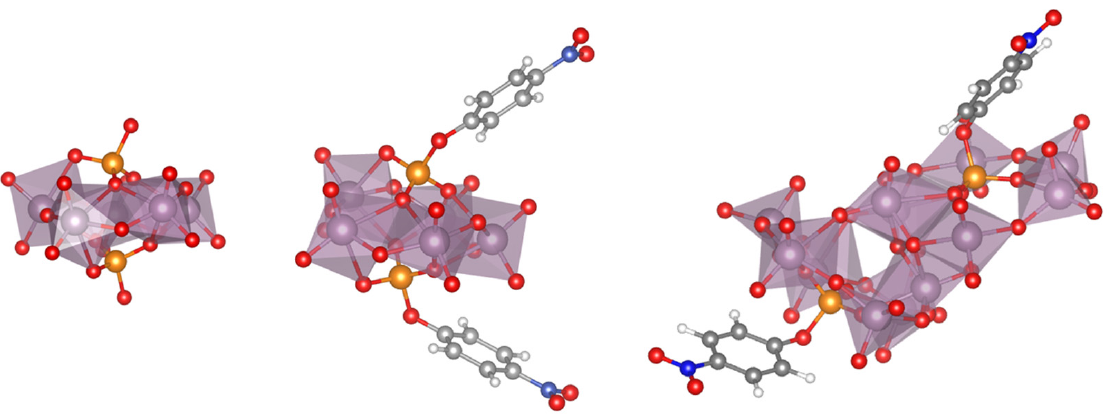
Figure 34. [P 2 Mo 5 O 23 ] 6– product ( left ) and [(pNPP) 2 Mo 5 O 21 ] 4– ( middle ) and [(pNPP) 2 Mo 12 O 36 (H 2 O) 6 ] 4– ( right ) intermediates involved in the mechanism proposed by Parac-Vogt et al. [31].